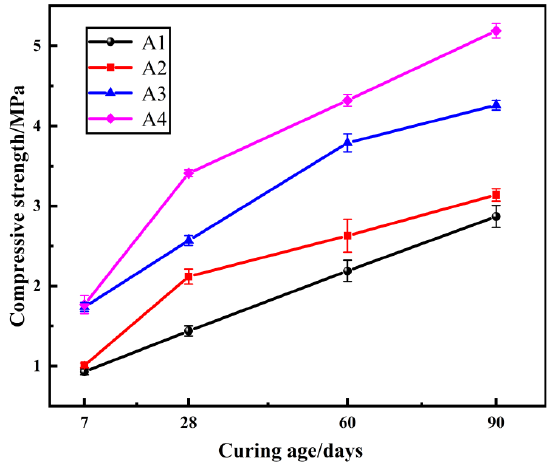
Figure 1. Strength of samples at different curing ages, varying the Na 2 O dosage.